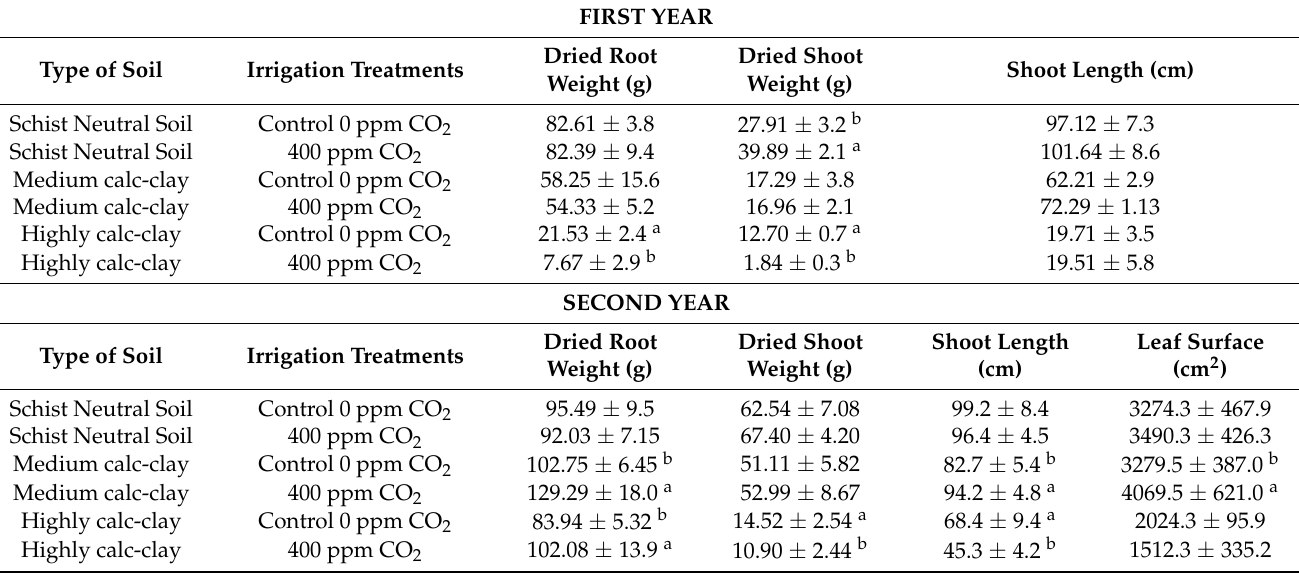
Table 9. Quantitation of dried weight (g), shoot length (cm), dried root weight (g), and leaf surface (cm 2 ) of V. vinifera (L.) cv. Tempranillo plants in pots with three different substrates. Treatments: schist soil, medium calcareous clay soil (medium calc-clay), and highly calcareous clay soil, treated with non-acidified water (control pH 7.5) and 400 ppm CO 2 -acidified water (pH 6.5). a,b : different letters denote a statistically significant difference ( p < 0.05) between treatment for the same type of soil. Values with different letters denote a statistically significant difference ( p < 0.05). The results show the mean value and standard